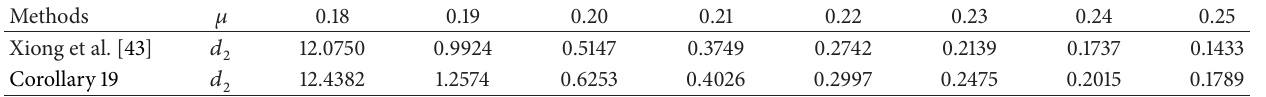
Table 7: Maximum upper bound of 𝑑 2 with Π 2 and different parameter 𝜇